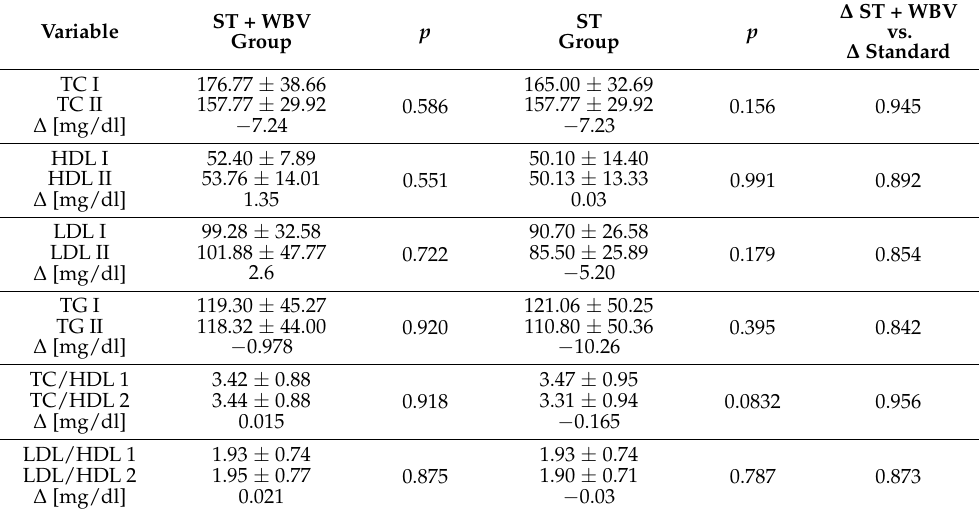
Table 5. Results of blood lipid profile test.